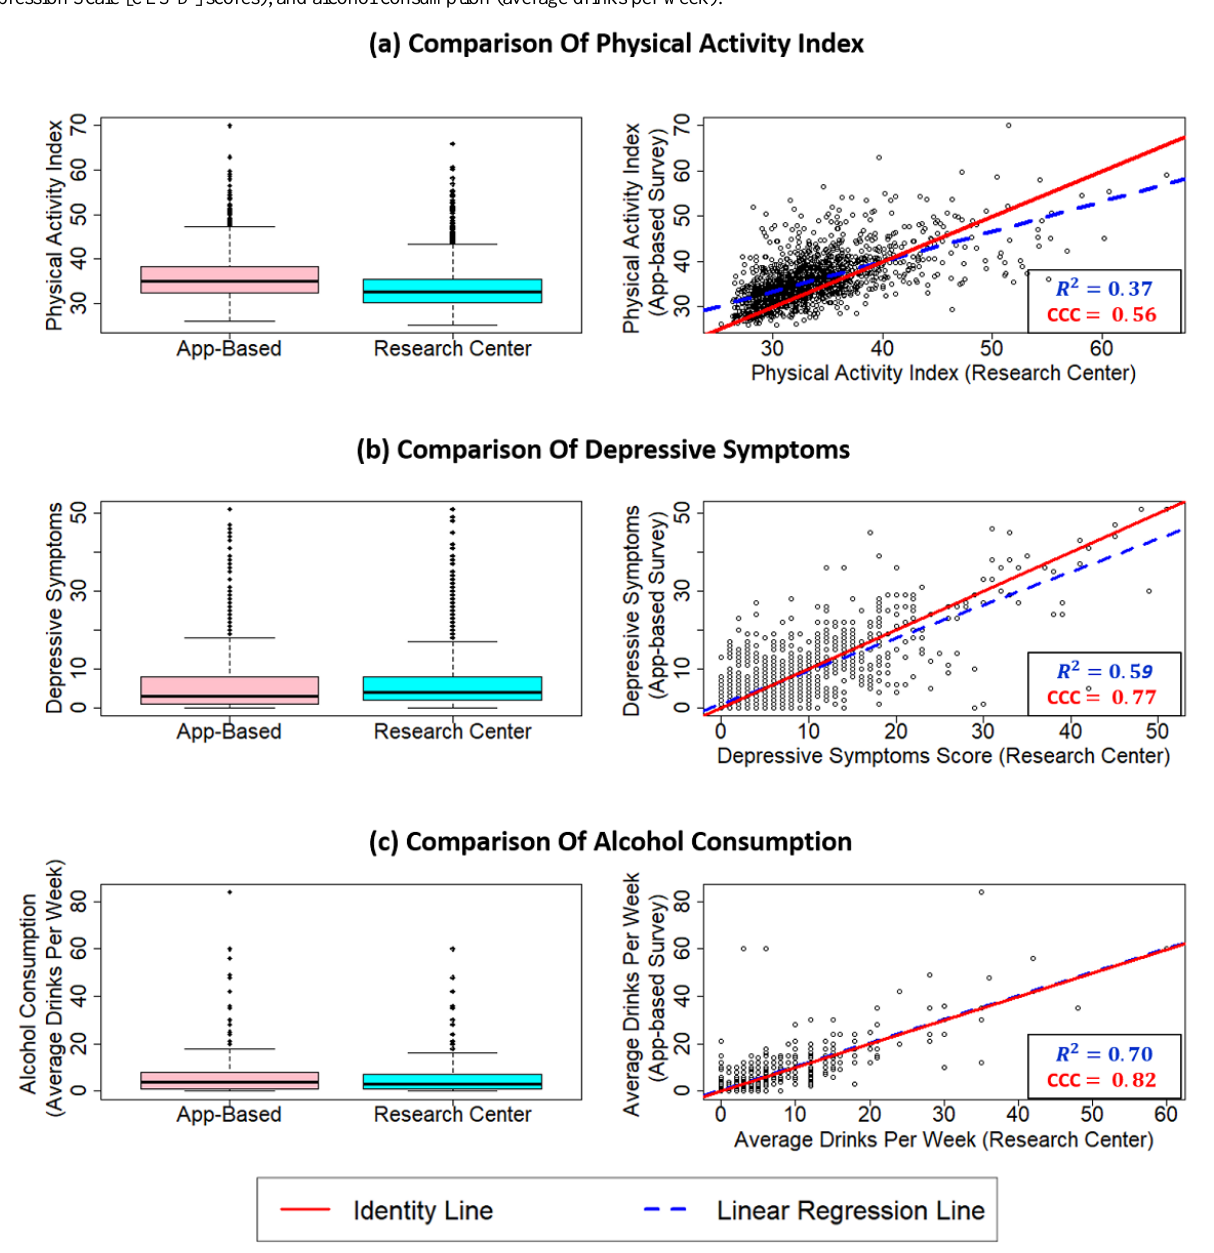
Figure 3. Comparison of baseline surveys: Physical Activity Index (PAI), depression symptoms scale (Sum of Center For Epidemiologic-Studies Depression Scale [CES-D] scores), and alcohol consumption (average drinks per